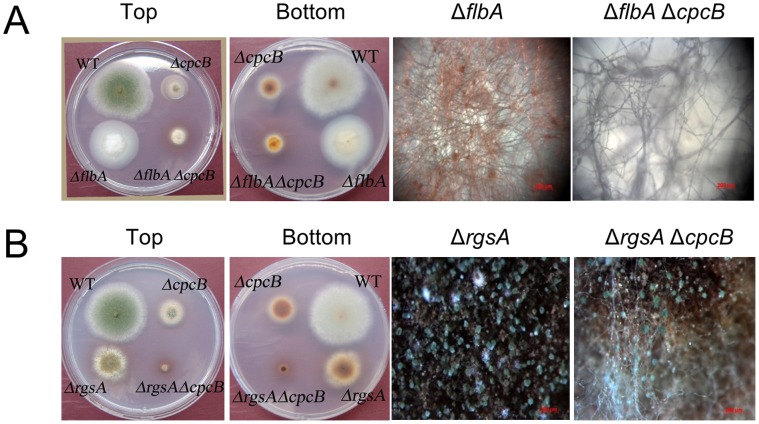
Phenotype of the ΔflbAΔcpcB and ΔrgsAΔcpcB mutants.Photographs of colonies of WT (FGSC4), ΔcpcB (RJMP1.59-8), ΔflbA (QK1), and ΔflbAΔcpcB (QK3) strains (A); and ΔrgsA (QK2) and ΔrgsAΔcpcB (QK4) strains (B) grown on solid MMG for 3 days are shown. The two left panels show the point-inoculated strains (top and bottom), and the two right panels show close-up views of single and double mutant colonies shown in the left panels. Photomicrographs were taken by Zeiss Axioplan 2 stereomicroscope. Note the highly restricted growth of the double mutants (A and B), and the lack of conidiation in the ΔflbA and ΔflbA ΔcpcB mutant (A).